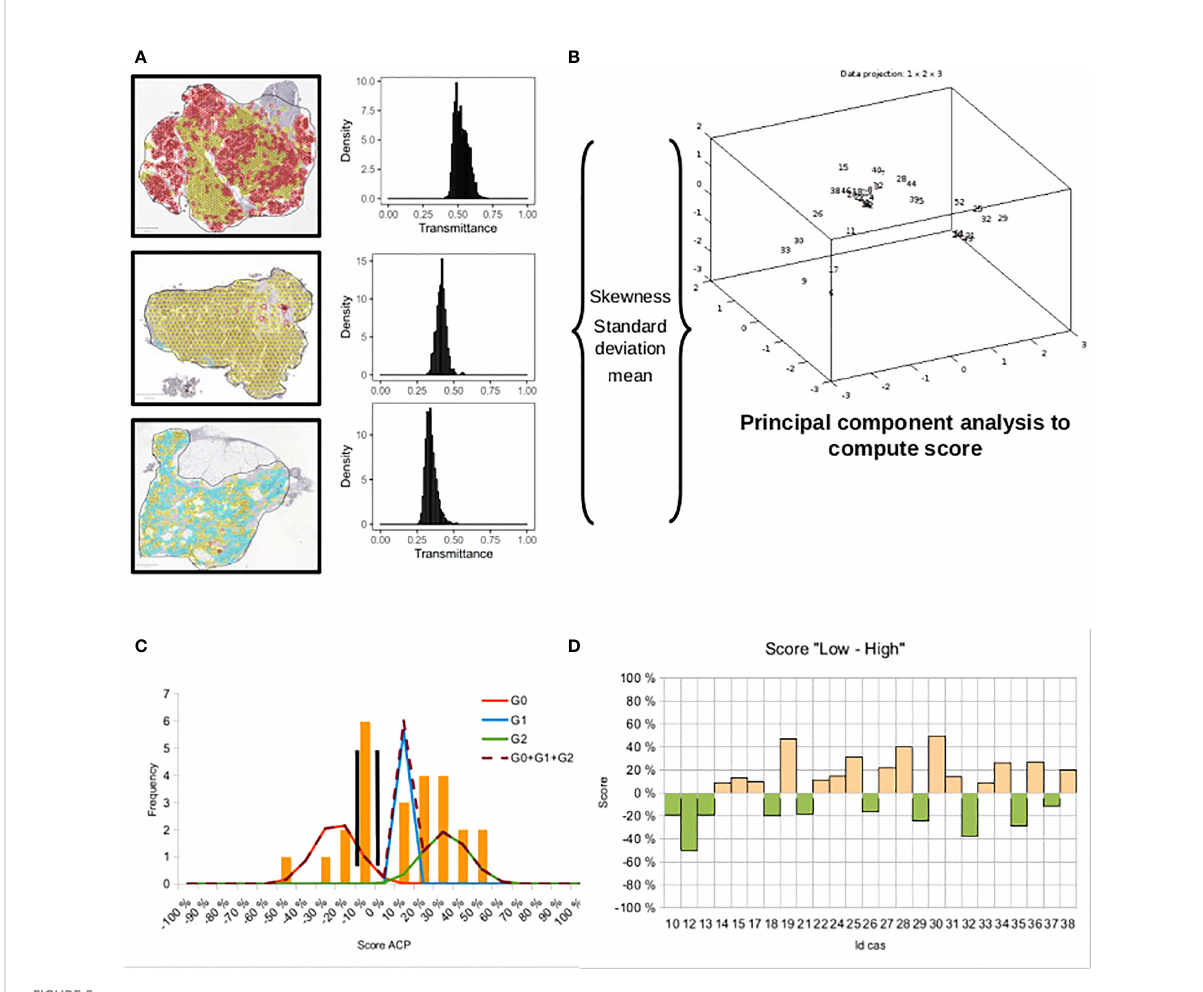
FIGURE 5 Complete procedure to compute an objective score taking distribution of staining of a speci fi c marker in hexagons into account. (A) On each section, intensity of staining in hexagons was computed to obtain distribution of transmittances. (B) Shape parameters of distribution were extracted for each section, and a principal component analysis was used to compute a score. (C) Distribution of scores was obtained from component 1 of PCA. To classify the patients as low or high score, a mixture of Gaussians was applied to fi nd thresholds. (D) The highest threshold was selected and used as the 0-value. Low scores are negative, and high scores are